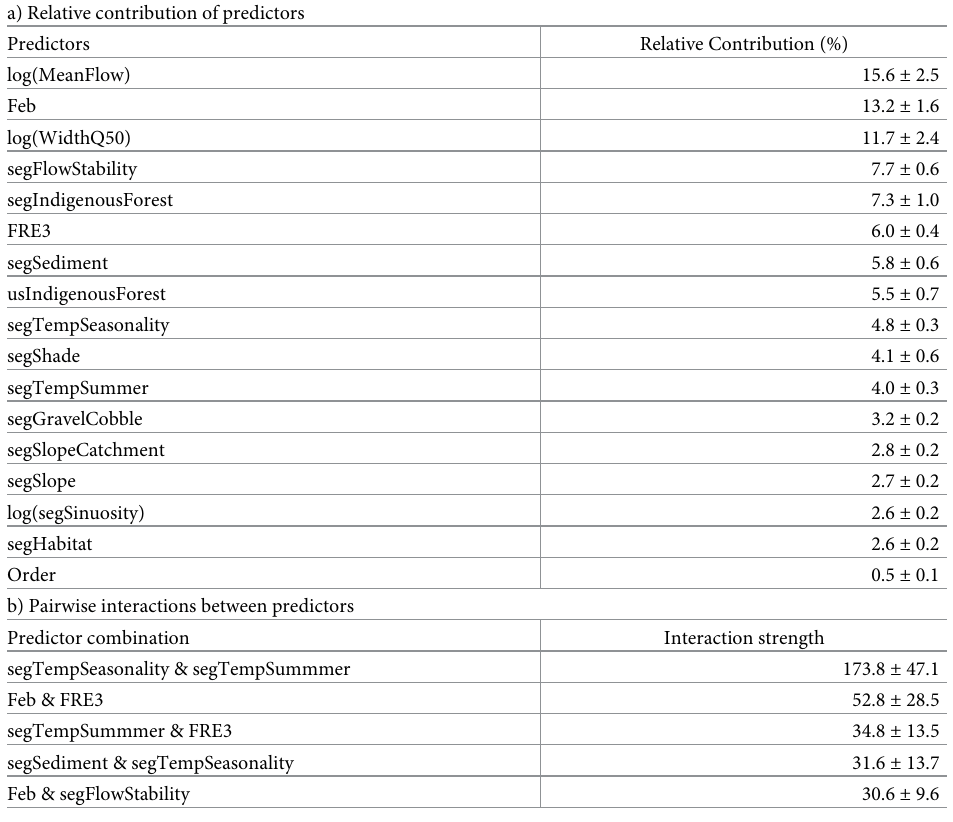
Table 2. Important predictors averaged across 200 bootstrapped boosted regression tree (BRT) models predicting the relative likelihood of occurrence (RLO) for whio across New Zealand. a) Relative contribution of